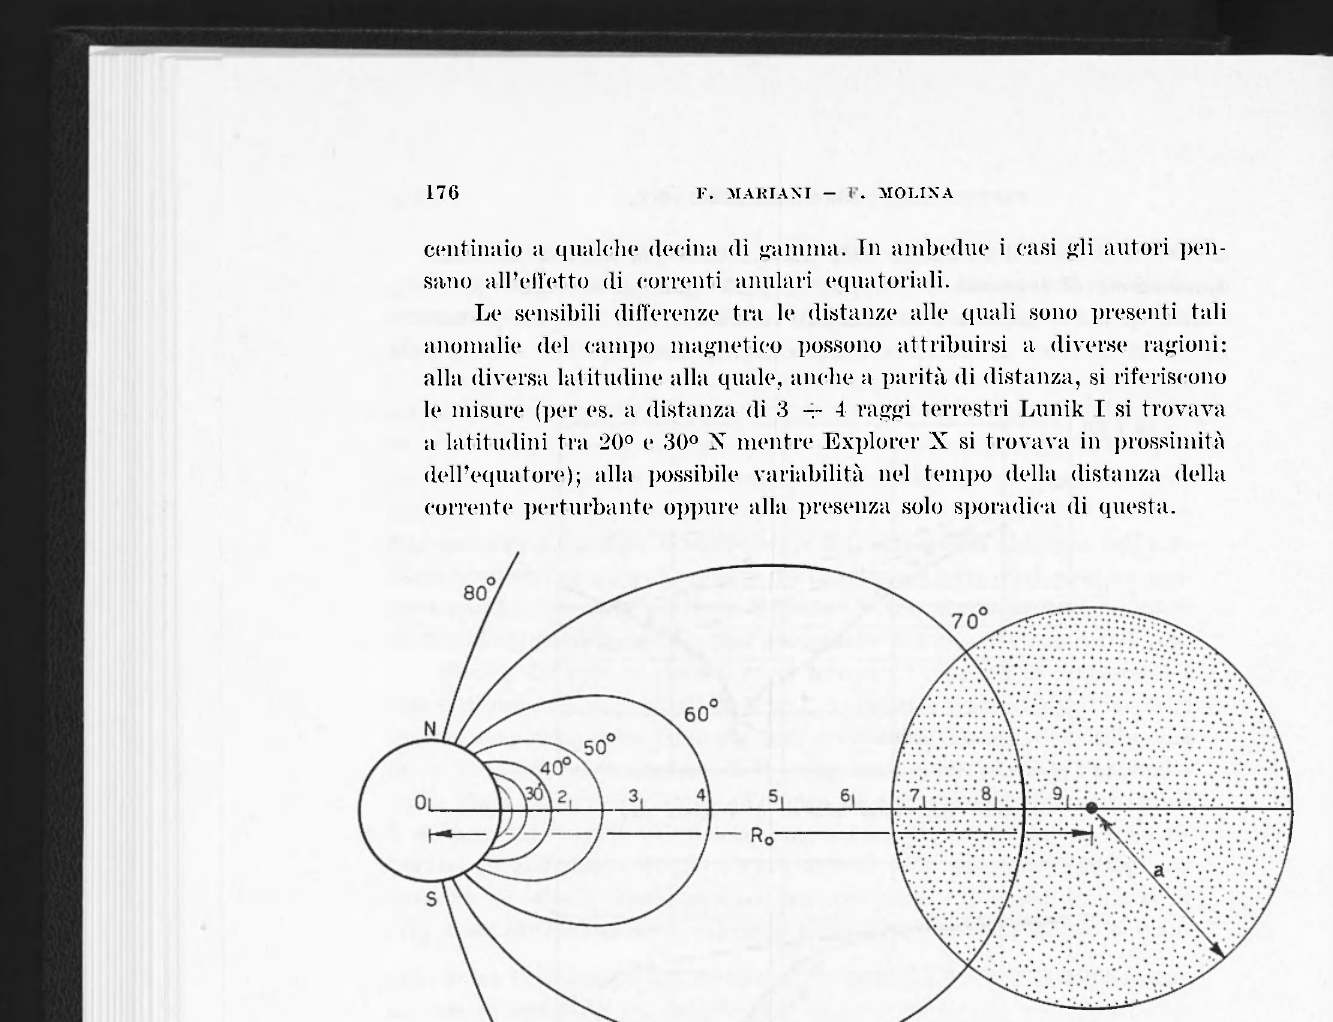
Fig. 5.7 Andamento delle linee di forza del campo di dipolo e sezione meridiana della corrente anulare equatoriale; le distanze geo- centriche sono in raggi terrestri; sono indicate le latitudini geomagnetiche alle quali le singole linee di forza intersecano la superficie terrestre (secondo Smith, Coleman, Judge e